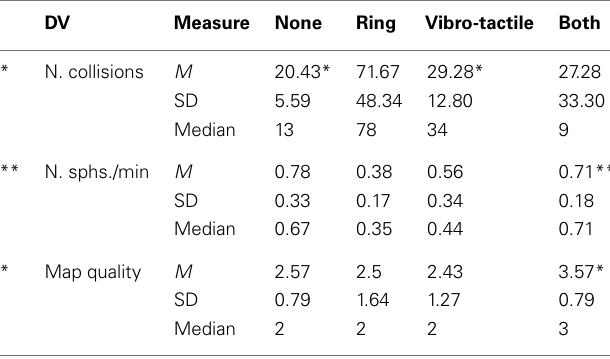
Table 1 | DV results for different interface treatments in study #1